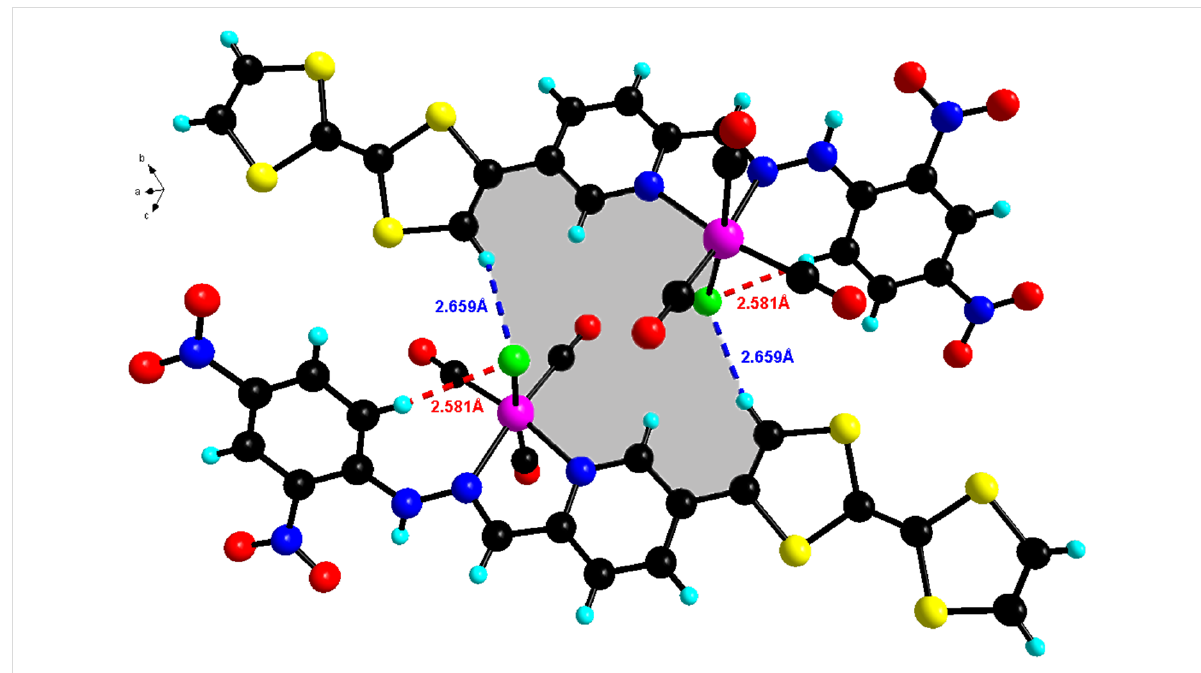
Figure 10: Pattern of intramolecular and intermolecular contacts in 3 . Two molecules are linked by pairs of strong TTF-C–H···Cl hydrogen bonds forming R 22 (16) cyclic motifs (in grey filling).